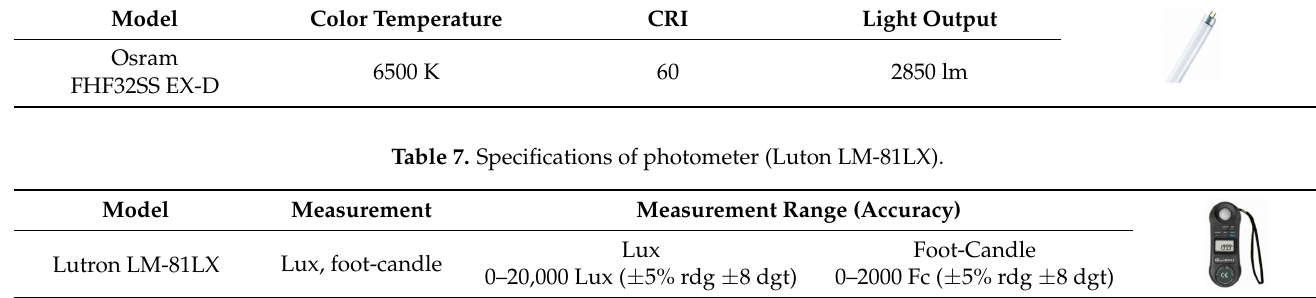
Table 6. Specifications of experimental environment artificial lighting (Osram FHF32SS EX-D). Model